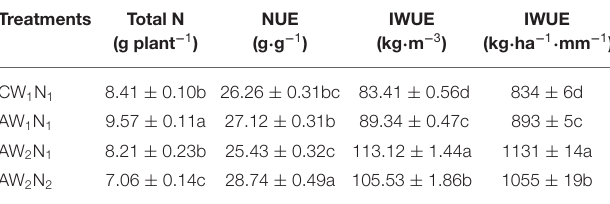
TABLE 3 | The effects of irrigation and N supply on the total plant N absorption, irrigation water (IWUE), and N (NUE) use efficiency under alternate partial root-zone drip N fertigation.